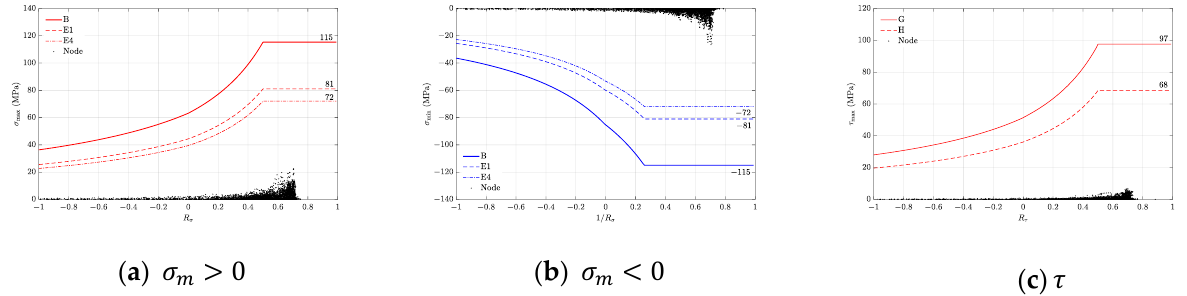
Figure 7. MKJ fatigue characteristic curve at weld position 1 in the sidewall.